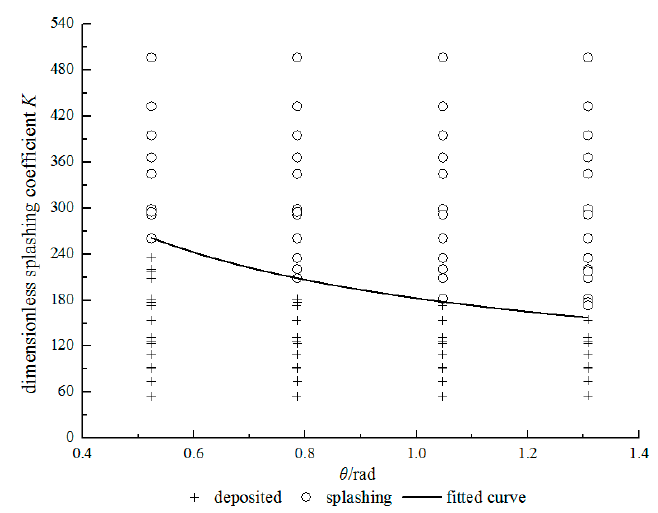
Figure 9. Distribution relationship between oil droplet deposition or splashing state and dimensionless splashing coefficient K.